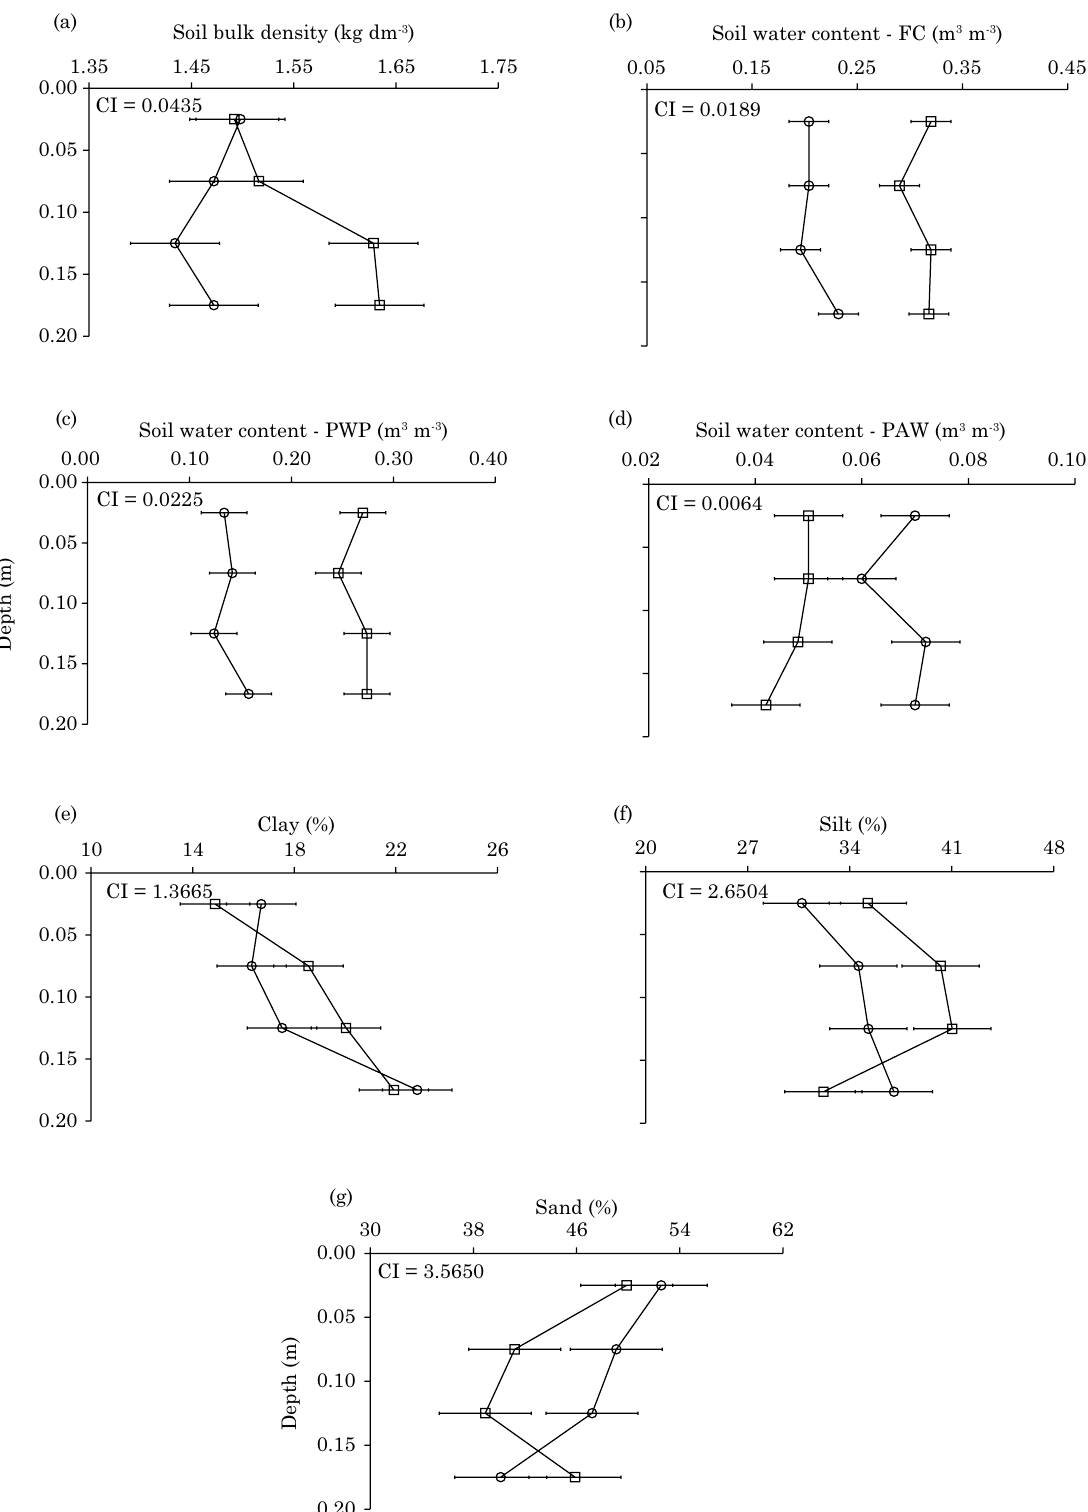
Figure 1. Soil bulk density - ρ b (a), volumetric water content (θ) at field capacity θ fC (h = 33 kPa) (b), permanent wilting point θ PWP (h = 1,500 kPa) (c), plant available water θ PaW (θ fC -θ PWP ) (d), and particle size distribution (clay, silt, and sand contents) (e-g) at the four depths (D1: 0-5 cm, D2: 5-10 cm, D3: 10-15 cm, and D4: 15-20 cm) under the arable cropping (○) and natural bush fallow (□) systems. Bars represent the confidence interval (CI)